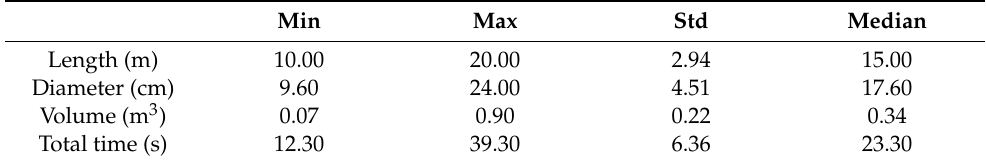
Table 2. Summary of time